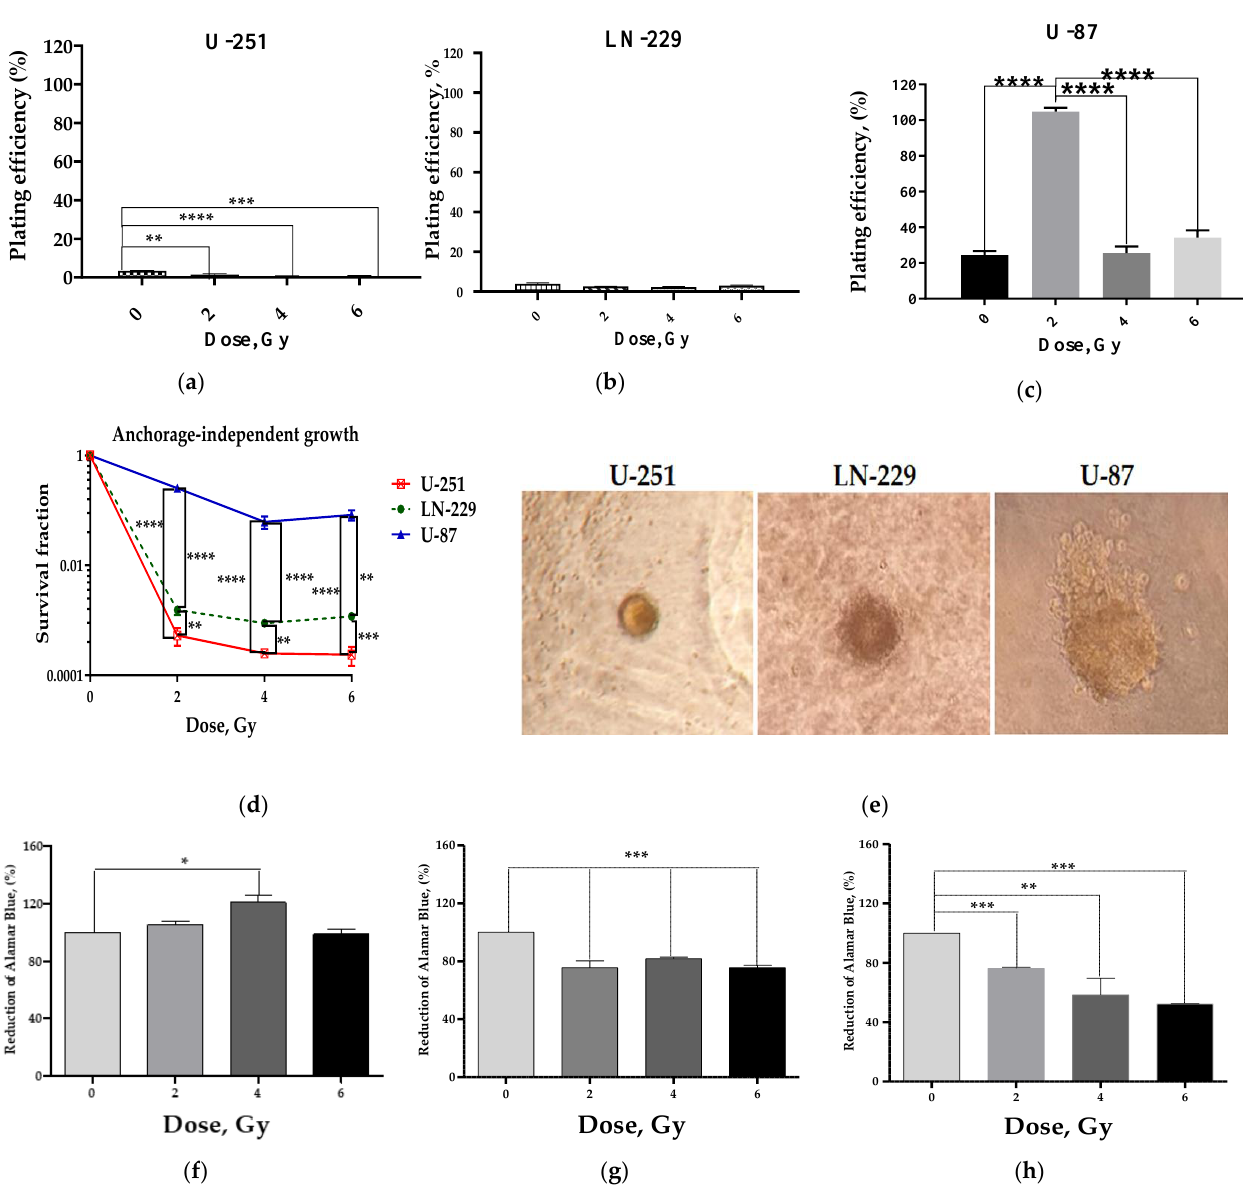
Figure 5. Anchorage-independent growth (soft agar colony formation assay) of ( a ) U-251, ( b ) LN-229, and ( c ) U-87 GBM cells exposed to acute 2 Gy, 4 Gy, and 6 Gy single doses of IR compared to non-irradiated control cells. ( d ) Survival fractions of control and their irradiated GBM lines after 21 days of cultivation after irradiation. ( e ) Representative light microscopic images of the colonies of GBM cell lines acquired at 20× magnification. Assessment of the mitochondrial NAD(P)H pro- duction activity of ( f ) U-251, ( g ) LN-229, and ( h ) U-87 cells one week after IR exposure to acute single doses of 2 Gy, 4 Gy, and 6 Gy compared to their control cells using alamarBlue assay (cells were seeded in soft agar in a 96-well plate at a concentration of 24 × 10 2 cells/0.32 cm 2 ). Data are means ± SEM of more than three independent experiments. * p ≤ 0.05, ** p ≤0.01, *** p ≤ 0.001, **** p ≤ 0.0001 . Notably, U-251 cells formed more dense colonies, compared to LN-229 and U-87 cells (Figure 5e). Most of the U-87-derived colonies were diffuse with a halo of cells mi- grating into the agar, indicating the highest invasiveness of cells constituting the colony. survival of GBM cell lines, we used a well-established alamarBlue assay in a 3D anchor-